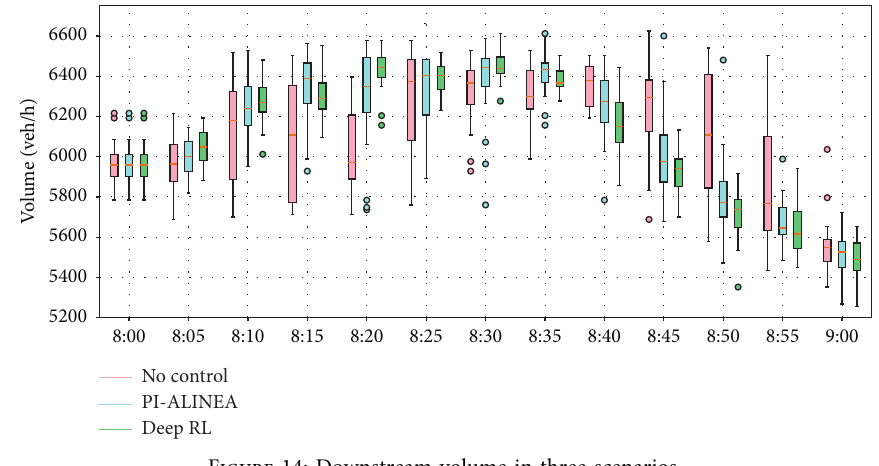
Figure 14: Downstream volume in three scenarios.